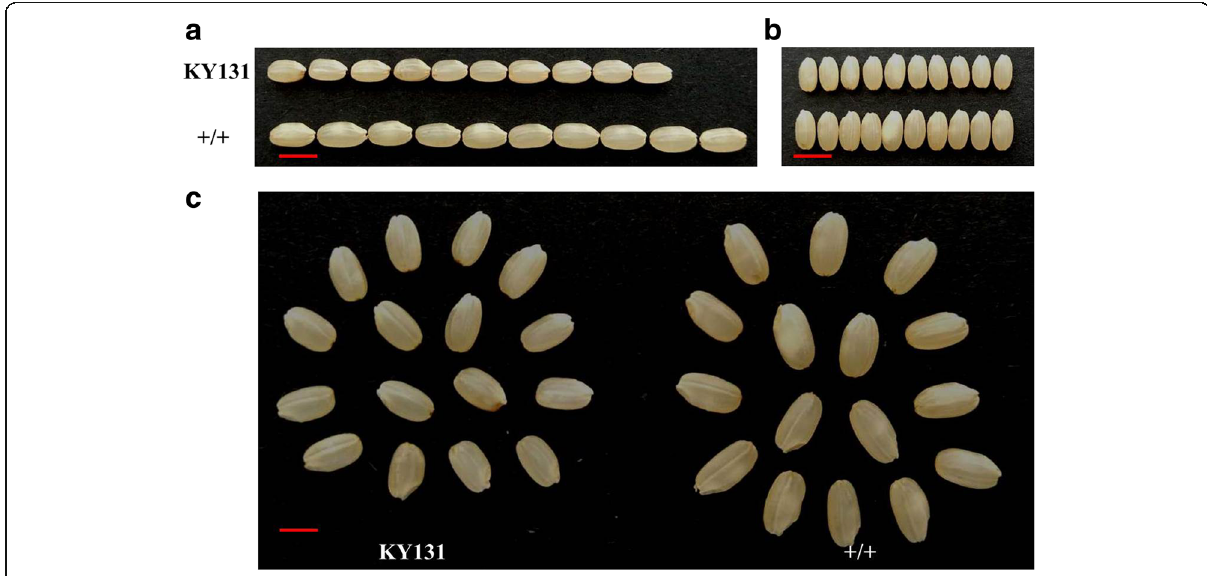
Fig. 6 Grain comparison between the improved line and Kongyu 131. a Grain length comparison. b Grain width comparison. c Grain appearance comparison between the improved line BC3F4 – 4 and Kongyu 131. Scale bar, 5 mm. KY131 is the abbreviation of Kongyu 131